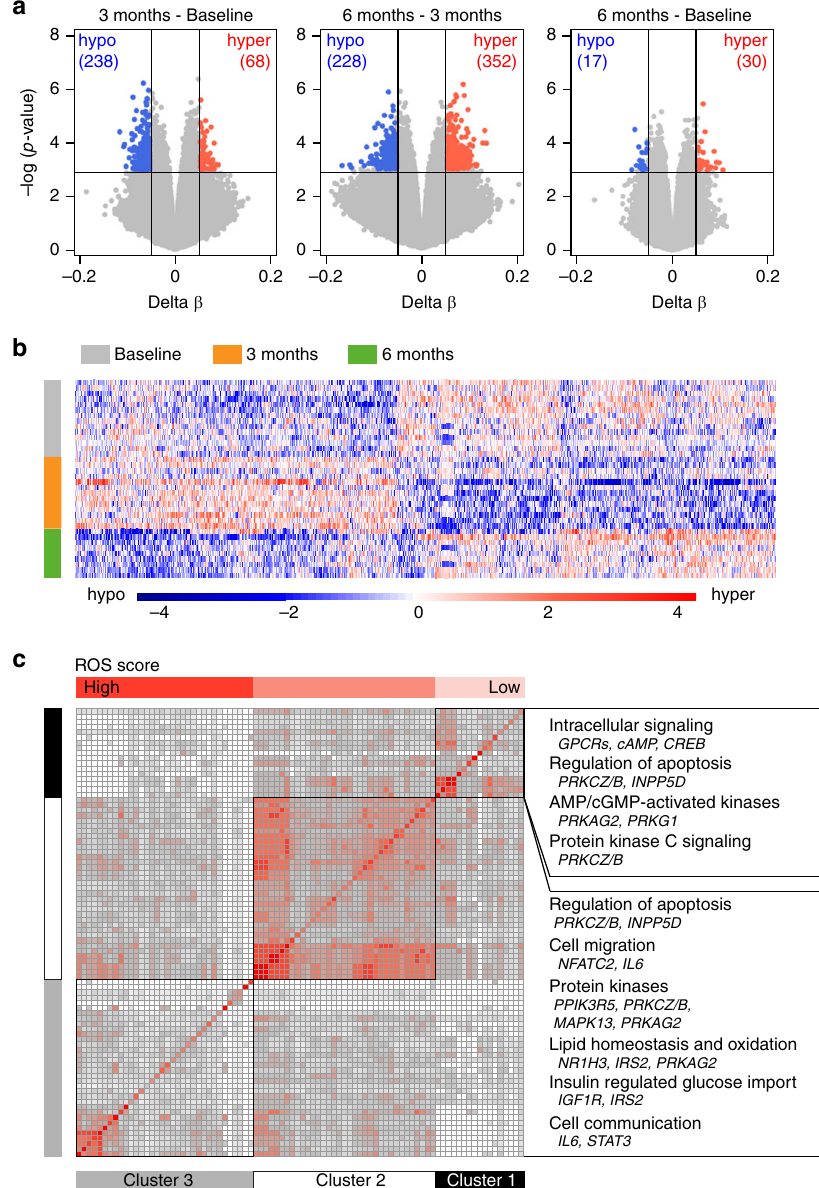
Fig. 3 Monocytes undergo DNA methylation changes at three months. a DNA methylation was measured using Illumina EPIC arrays in CD14 + monocytes sorted from peripheral blood of RRMS patients before (baseline; BL, n = 14) treatment with DMF as well as three and six months following the treatment (M3 n = 12 and M6 n = 9). Volcano plots illustrating differences in DNA methylation between different time points following DMF treatment. Hyper- and hypo-methylated CpGs with min 5% methylation change and P < 0.001 (Linear model testing) are indicated in red and blue, respectively. b Heat map of 1614 most signi fi cant differentially methylated CpG sites between the time points (the scale represents z -score). c Clusters of canonical pathways, derived using Ingenuity Pathway Analysis, suggest functions that are affected in monocytes following DMF treatment. The signi fi cance of pathways was determined with the right-tailed Fisher ’ s exact test ( P < 0.05) and the clustering was performed on the relative risk for the overlap of molecules between the pathways using k-means. The horizontal top bar indicates the degree of overlap with selected ROS genes. Summary of the key functions and their constituent genes that displayed changes in DNA methylation upon DMF treatment are given to the